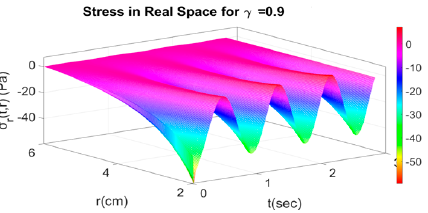
Figure 4. Distribution of the radial stress 𝜎 (cid:3045) (𝑡,𝑟) in the initial space for γ = 0.9.